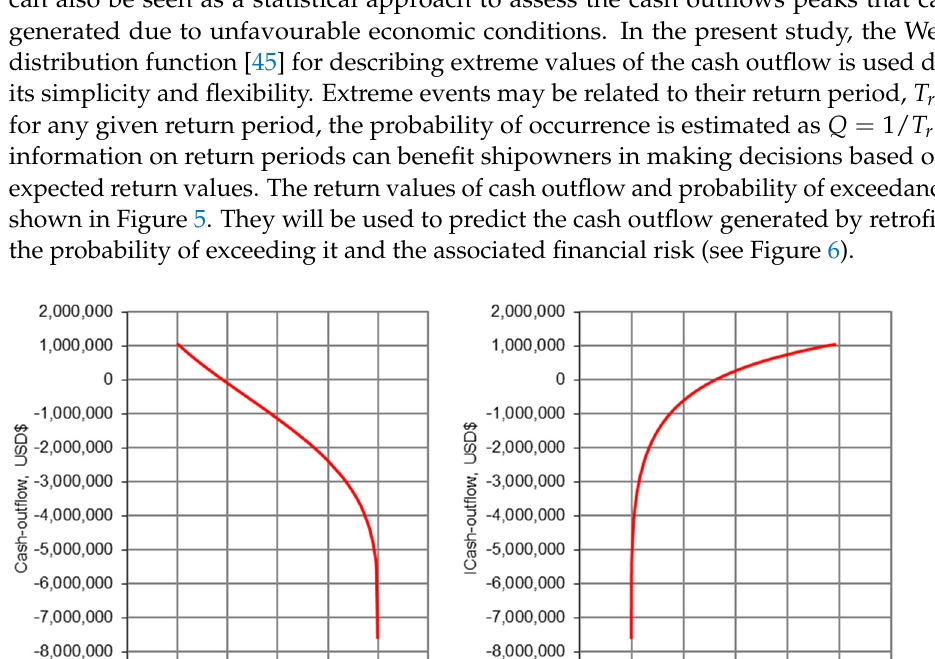
Figure 7. Financial risk as a function of cash-outflow.